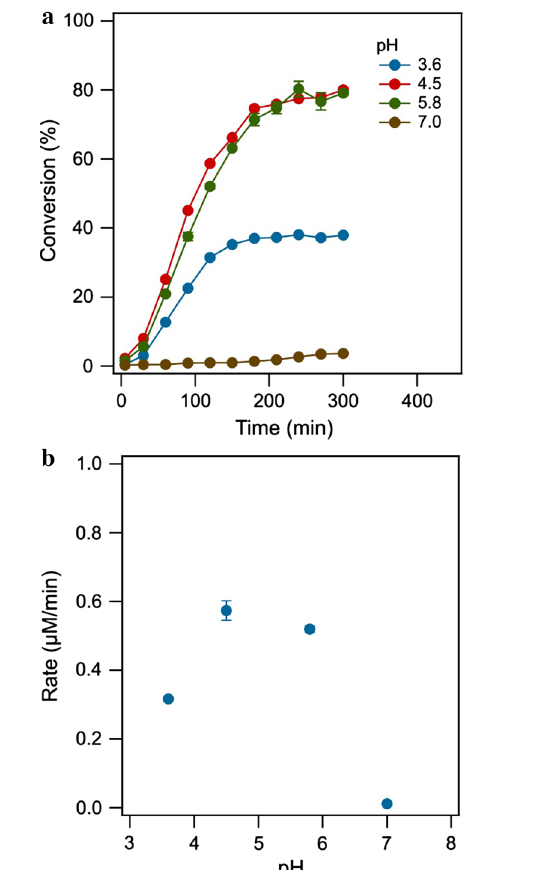
Fig. 6 The effect of pH on the conversion of ABTS ( a ) and the rate of product formation ( b ) by DMELC (temperature, 30 °C, shaking speed, 180 rpm, ABTS concentration, 100 μM, 2.0 mg